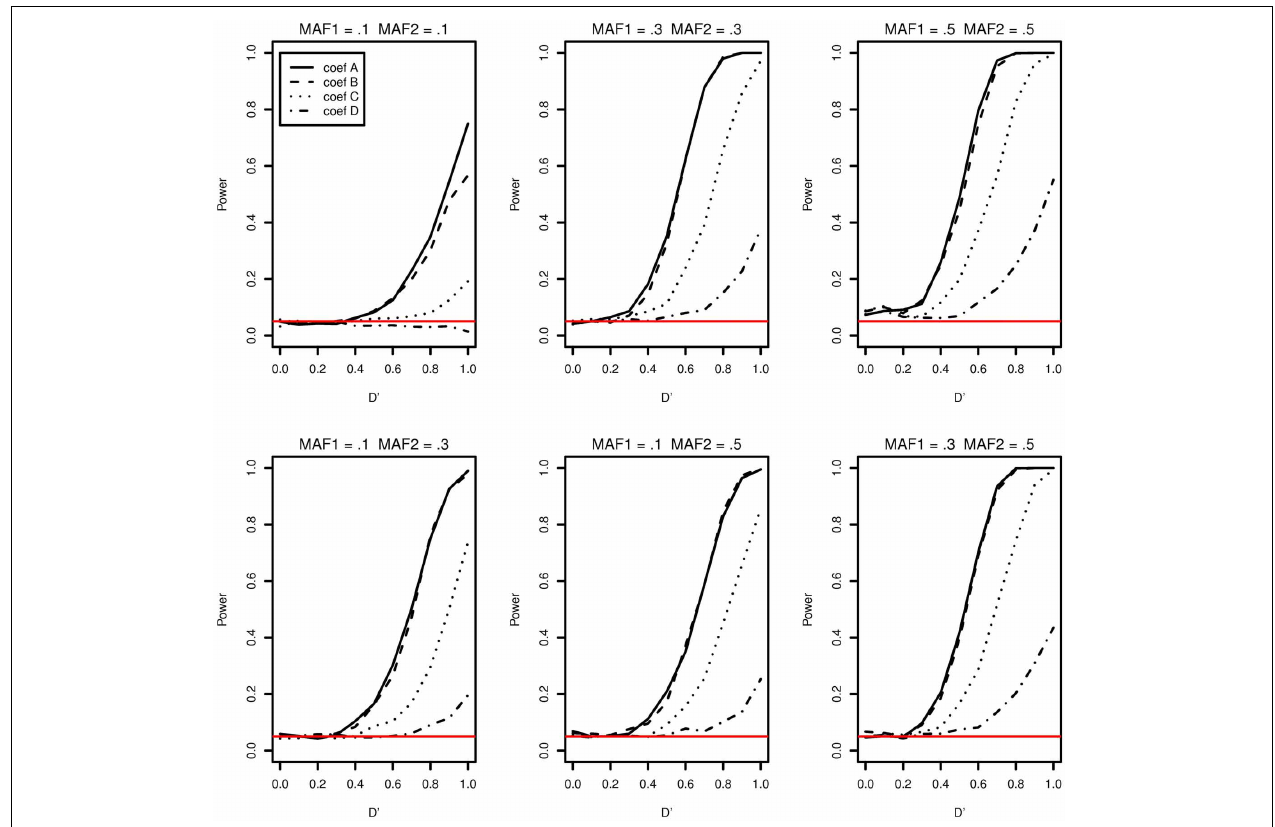
coef C : β 1 = 0 . 5, β 2 = 0 . 5, and β 12 = 0 . 5, coef D : β 1 = 0 . 75, β 2 = 0 . 75, and = 0 . 5 and σ 2 = 1, when the sample size is 2000 (1000 β 12 = 0 . 25, and σ 2 a e families). The red horizontal line indicates the 0.05 significance